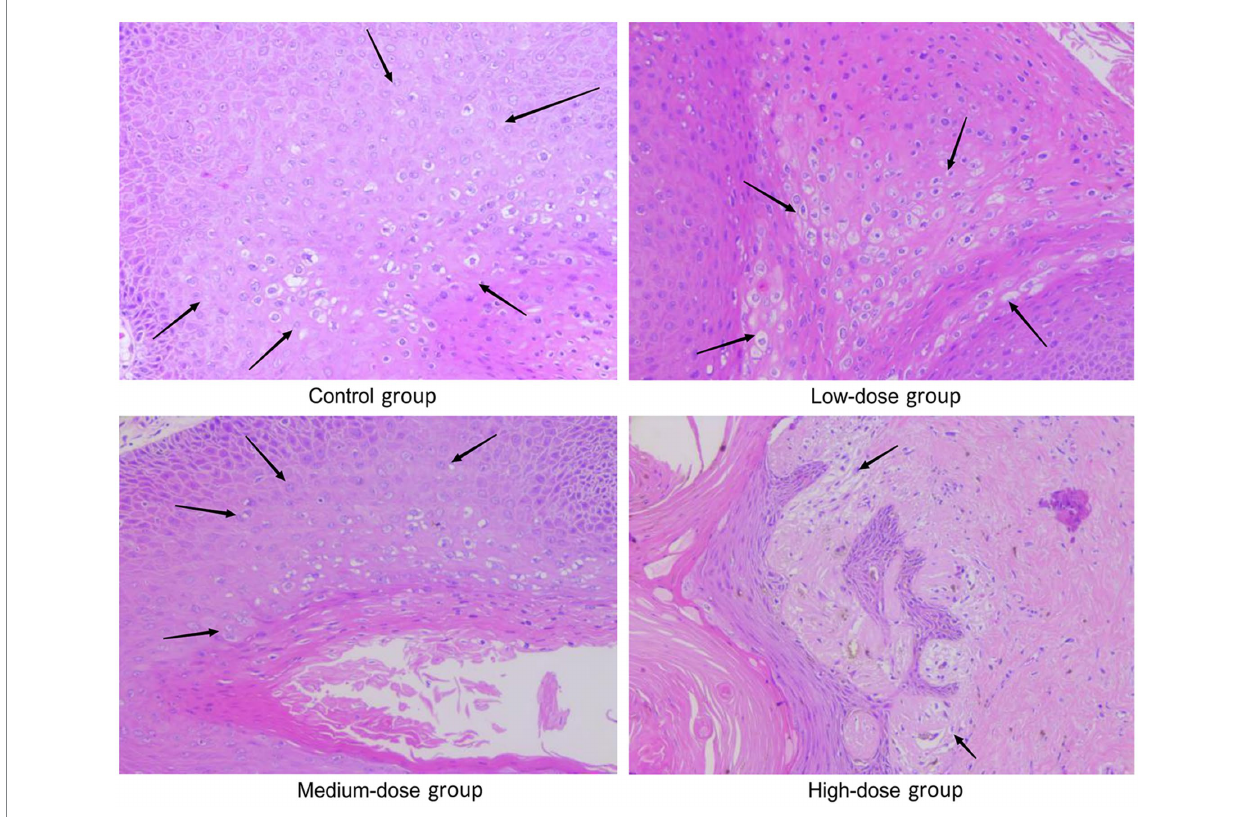
FIGURE 4 Representative images of H&E staining of the wart xenografts in the different groups of nude mice. Magnification, × 200. In the model control group, as arrows shown koilocytes around the nucleus of local epithelial cells, and the nucleolus of the nucleus were observed; in the low-dose and medium- dose groups, as arrows shown, koilocytes around the nucleus of local epithelial cells, and the nucleolus of the nucleus were observed. In the high- dose chloroquine phosphate gel-treatment group, hyperkeratosis of the epidermal cells of the wart body, squamous epithelium under the epidermis, local epithelial cell degeneration and necrosis was visible, and a small quantity of koilocytes could be seen locally, just as arrows